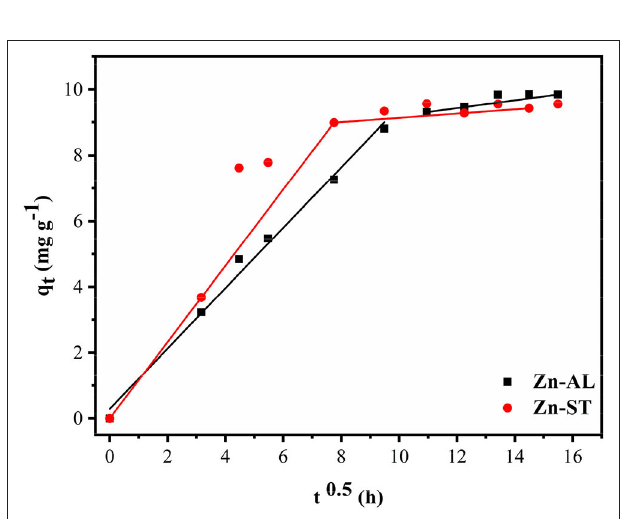
FIGURE 11 | An intraparticle diffusion model for Cu (II) removal using Zn-AL and Zn-ST as adsorbent.